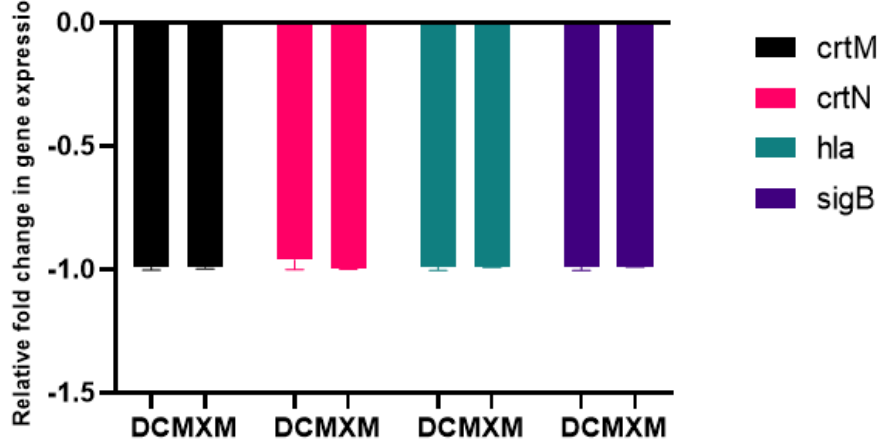
Figure 10. Comparing the effects of DC treatment vs. MXM treatment (at their sub-MICs of 47 µg/mL and 59 µg/mL for DC and MXM respectively) on the level of virulent gene expression. Error bars indicate SDs from the mean. 2.12. Molecular Docking Molecular docking analysis, as shown in Figures 11 and 12, validated the ability of both DC and MXM to bind to the CrtM protein of MRSA. Both drugs were found to effi- ciently bind to the enzyme with several hydrogen bonds and hydrophobic bonds. Molec- ular modeling results are presented in Table 2. The results demonstrate the ability of both